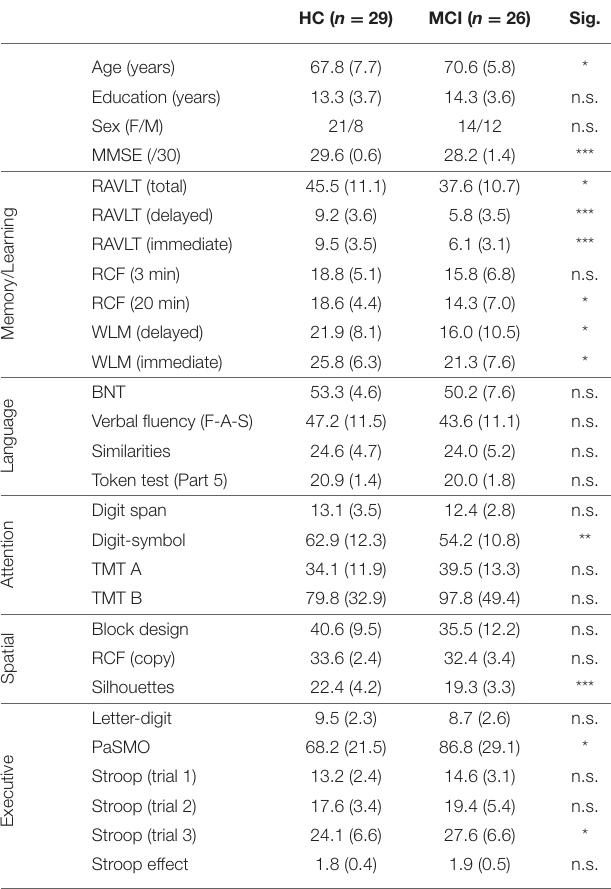
TABLE 1 | Demographic information and neuropsychological test scores, by group (mean and standard